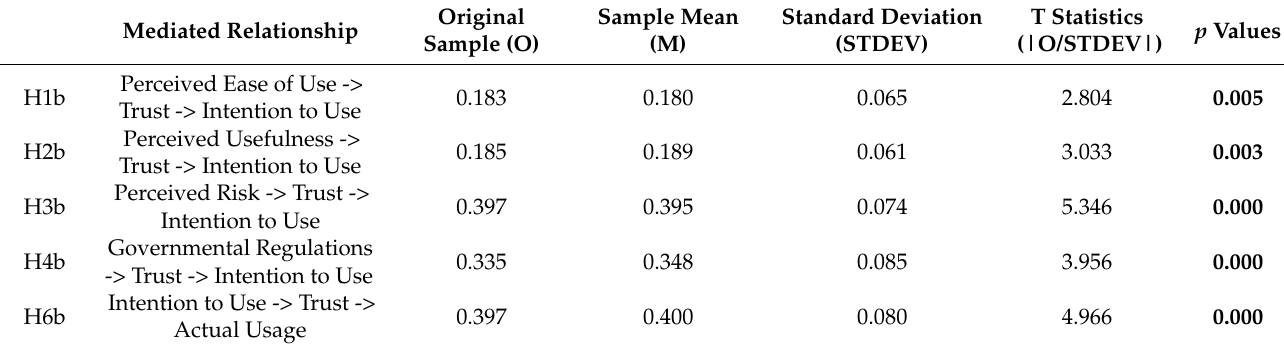
Table 6. Mediation Analysis (Indirect